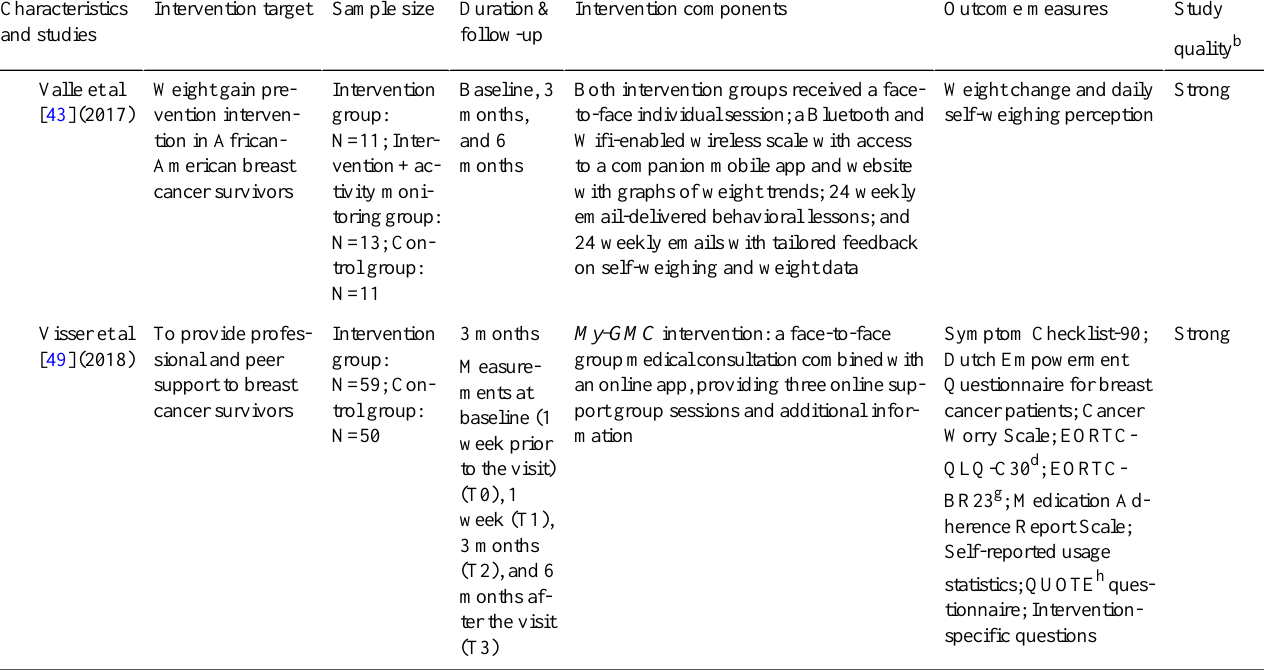
IBIS: International Breast Cancer Intervention Study. d EORTC-QLQ-C30: European Organization for Research and Treatment Cancer Quality of Life Questionnaire - Core 30. e mMBSR(BC): mobile Mindfulness-Based Stress Reduction for Breast Cancer. f FACT-G: Functional Assessment of Cancer Therapy - General. g EORTC-BR23: European Organization for Research and Treatment Cancer Quality Of Life Questionnaire - Breast Cancer Module. h QUOTE: Quality of Care Through the Patient’s